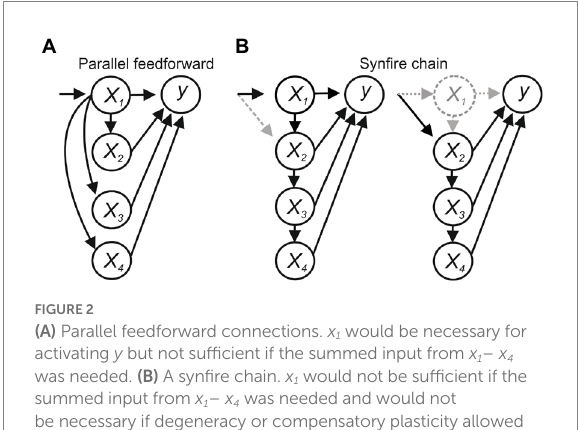
FIGURE 2 (A) Parallel feedforward connections. x 1 would be necessary for activating y but not sufficient if the summed input from x 1 – x 4 was needed. (B) A synfire chain. x 1 would not be sufficient if the summed input from x 1 – x 4 was needed and would not be necessary if degeneracy or compensatory plasticity allowed x 2 – x 4 to activate y